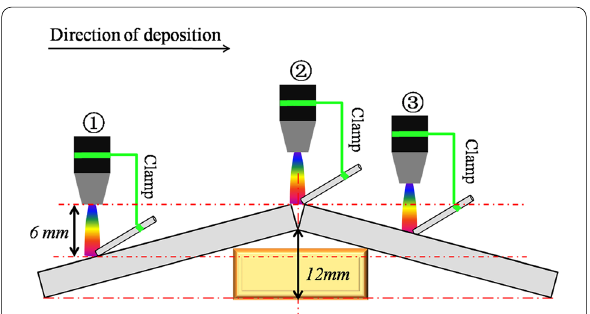
Figure 13 Schematic diagram of process of depositing molten wire material on sloping substrate